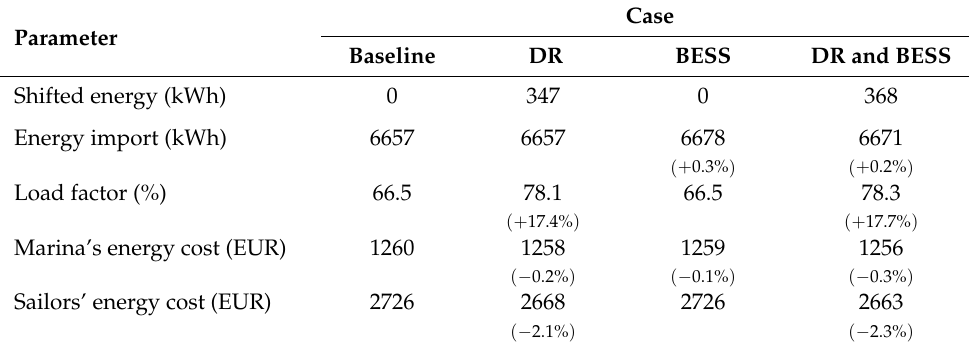
Table 4. Simulation results for DR and BESS in